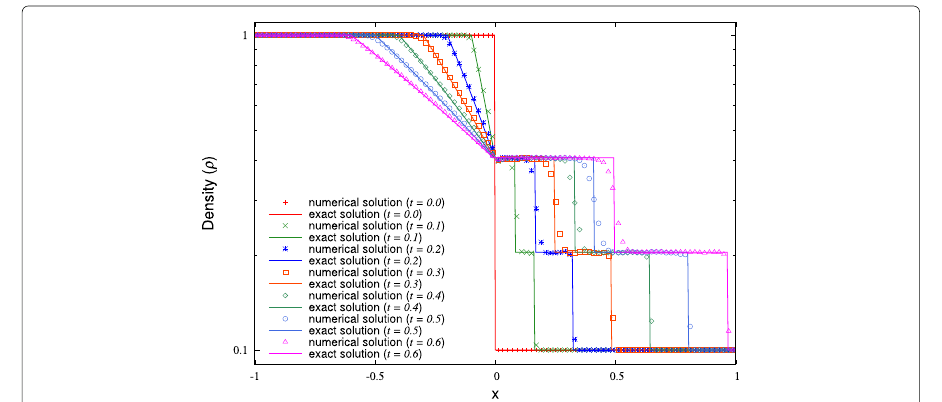
Fig. 7 Comparison of density with the exact solution (shock tube test)